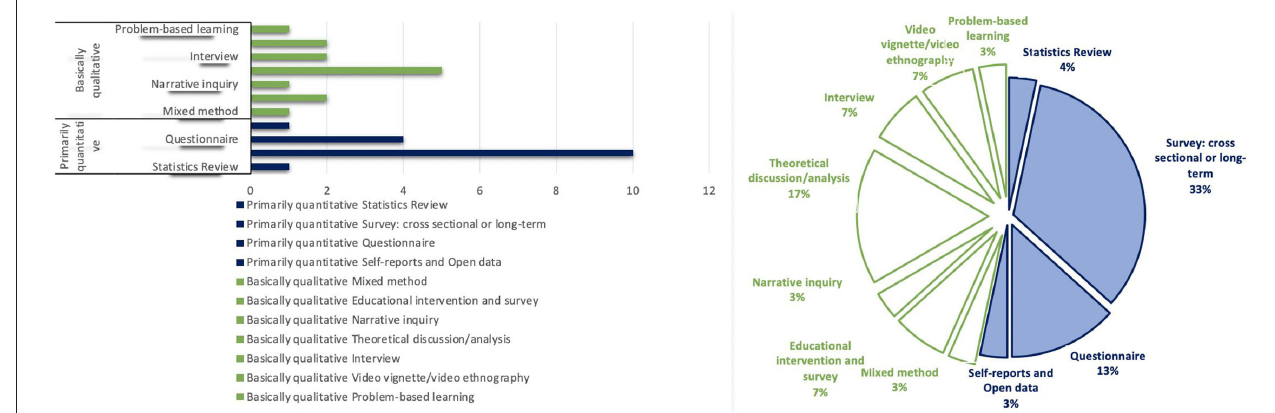
FIGURE 4 | Methodological approaches to tacit knowledge.